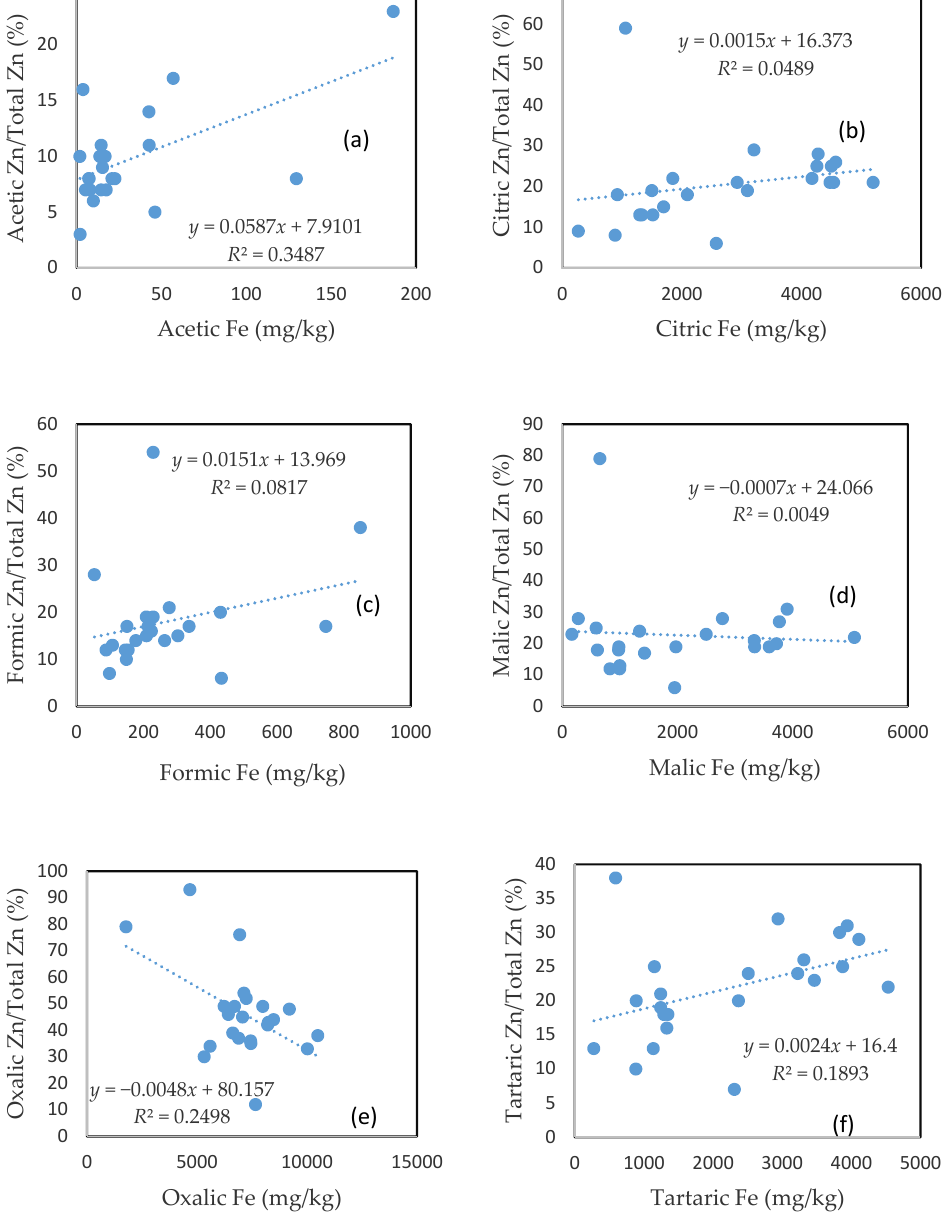
Figure 5. Relationship between the amount of Fe released from the soil and the rate of Zn mobilization in ( a ) acetic acid; ( b ) citric acid; ( c ) formic acid; ( d ) malic acid; ( e ) oxalic acid; and ( f ) tartaric acid